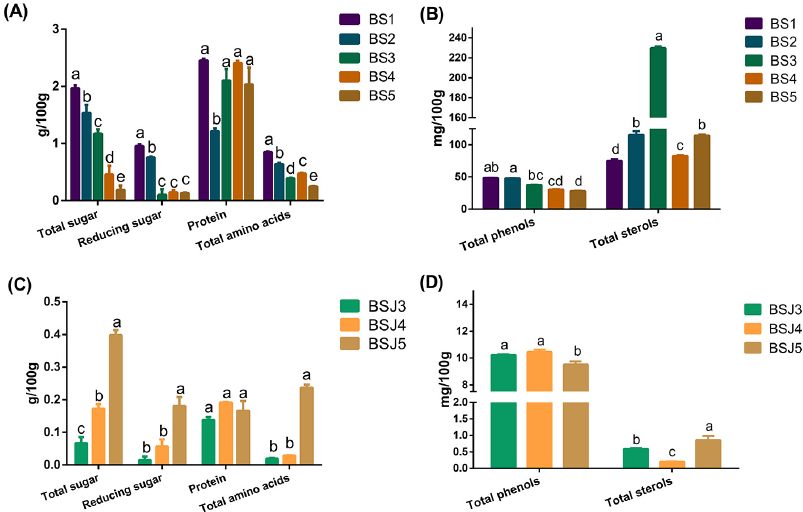
Figure 2. Histogram of changes in nutrients during processing. a, b, c, d indicate significant differences ( p < 0.05), and all data are calculated on a wet basis; ( A , B ) were the changes of main nutrients in bamboo shoots during processing; ( C , D ) were the changes of main nutrients in bamboo shoots soaking solution during processing.